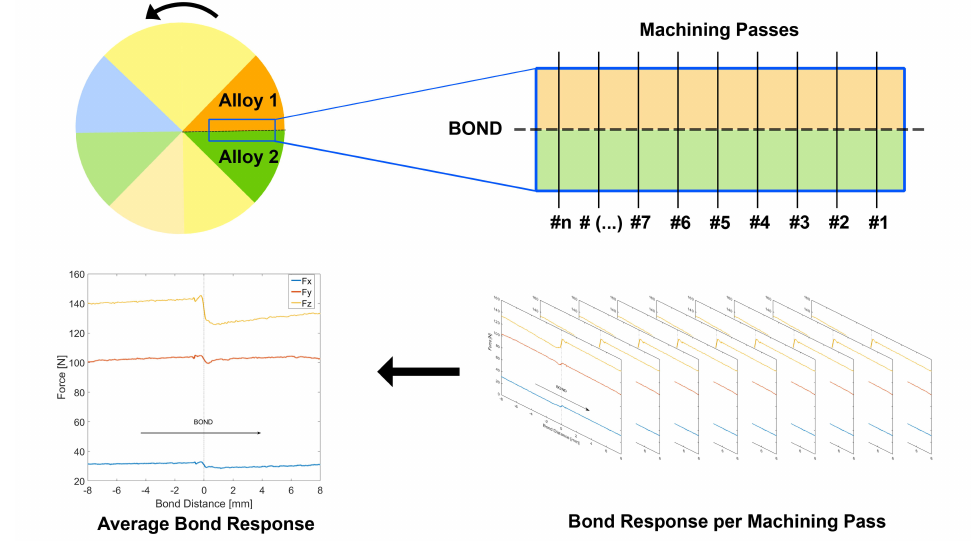
Figure 3. Graphical representation showing where data is extracted from and how the average forces in the bond are